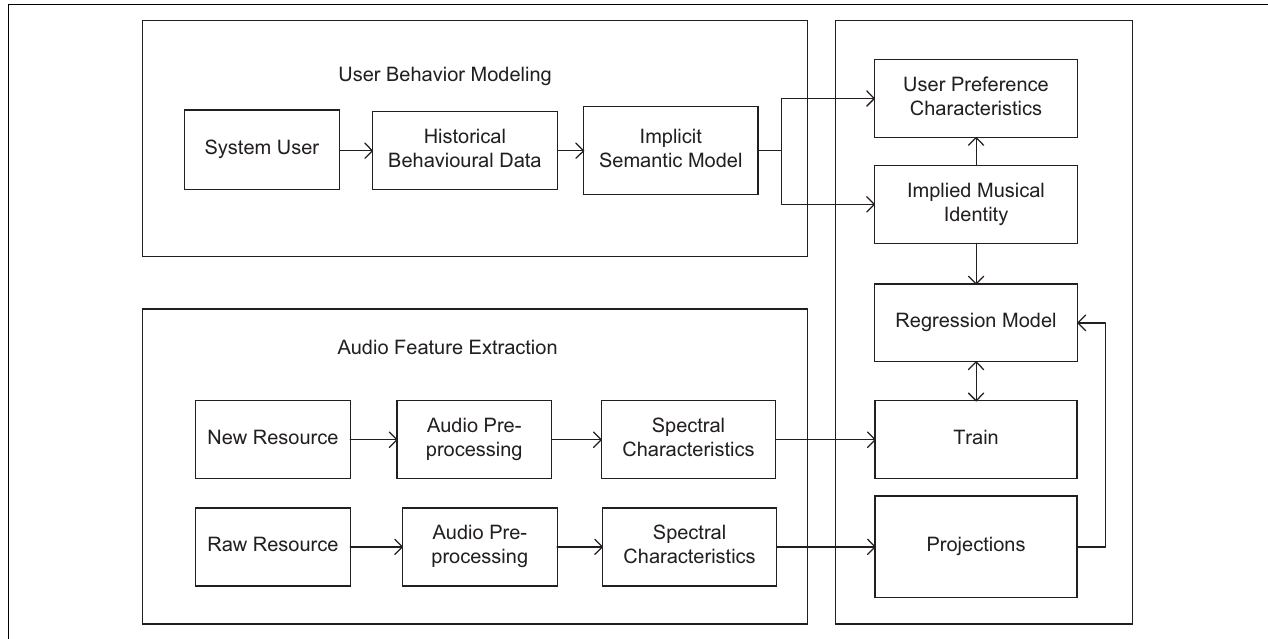
FIGURE 1 | CNN-based music recommendation model.